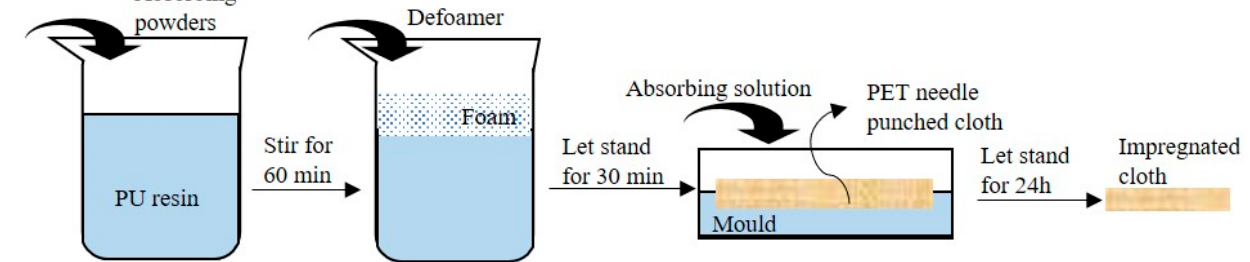
Figure 2. Preparation process of microwave-absorbing impregnated nonwoven fabric.